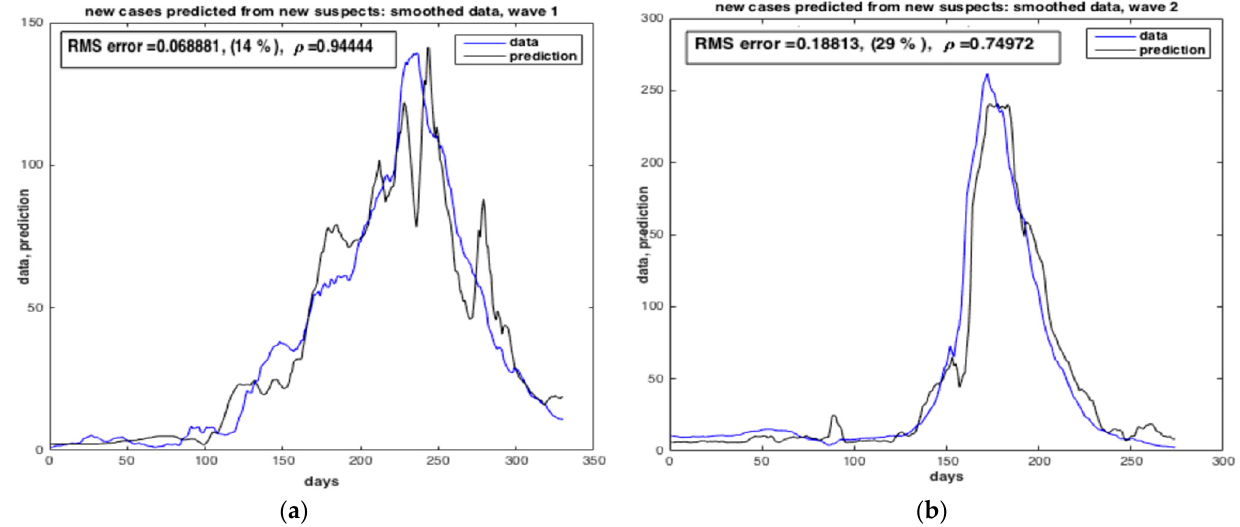
Figure 20. Estimation of the number of infected cases by SARS-CoV-2 in Morocco predicted from the number of suspected cases. ( a ) Case of 𝛼 wave. ( b ) Case of Δ wave. The results furnished by COL.